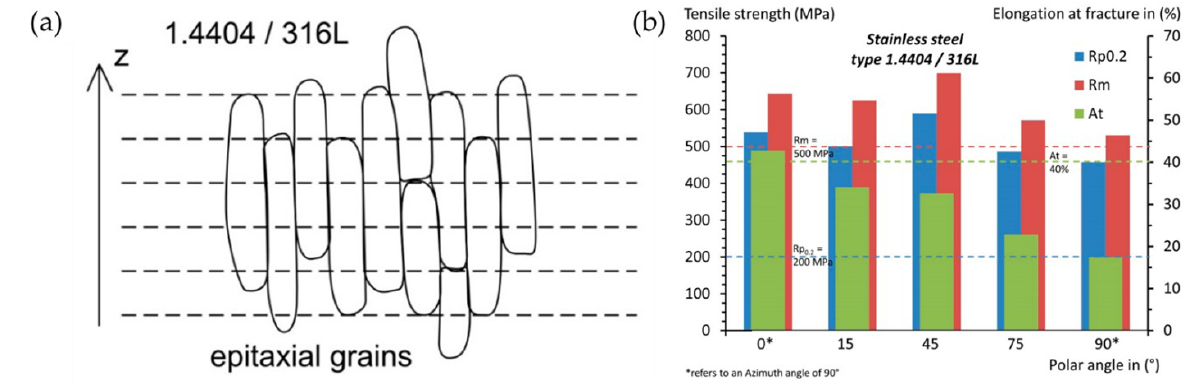
Figure 5. The ( a ) epitaxial grain formation that governs anisotropic mechanical strength and its ( b ) performance under different polar angles